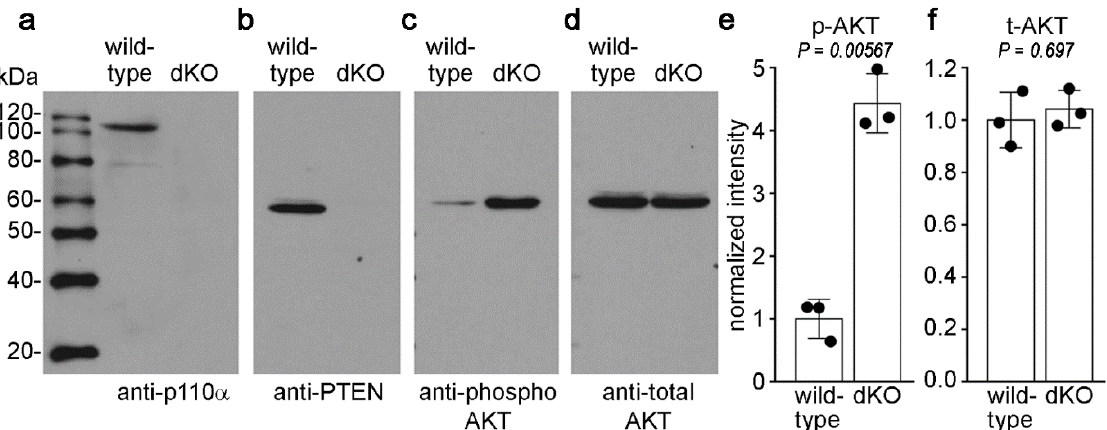
Figure 3. Double deletion of p110α/PTEN increased levels of phospho -AKT. Lens capsules with attached epithelial cells were isolated from 3 week old WT or dKO lenses, and used for western blots. Blots were probed with antibodies against p110α, PTEN, phospho, or total AKT. Both p110α ( a ) and PTEN ( b ) proteins failed to be detected in dKO lenses. ( c ) As previously reported for single PTEN KO lenses [14] , phospho-AKT (p-AKT) levels were elevated in dKO lenses. ( d ) Total AKT (t-AKT) levels were the same in wild-type and dKO lenses. Quantitation of band intensities showed a ~4.5-fold increase in p-AKT levels in dKO lenses ( e , p < 0.05, two sample t -test), and no significant differences in t-AKT levels between wild-type and dKO mice ( f , p > 0.05 two sample t -test). Raw data are plotted as filled circles, bars represent the mean ± SD, n = 3.